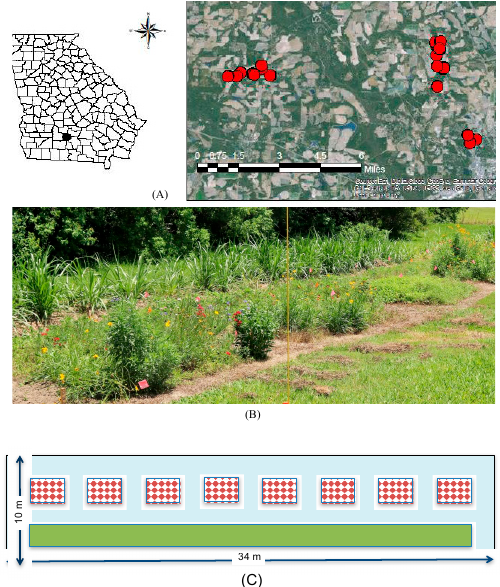
Figure 1. Buffer plots distributed across experimental farm stations at University of Georgia in Tift County, Georgia ( A ), photograph of experimental plot ( B ). Bottom panel ( C ) with plot design including eight randomized wildflower subplots (red checkered boxes) and one Napier grass subplot (green box), with vegetation free allies around all subplots (blue).